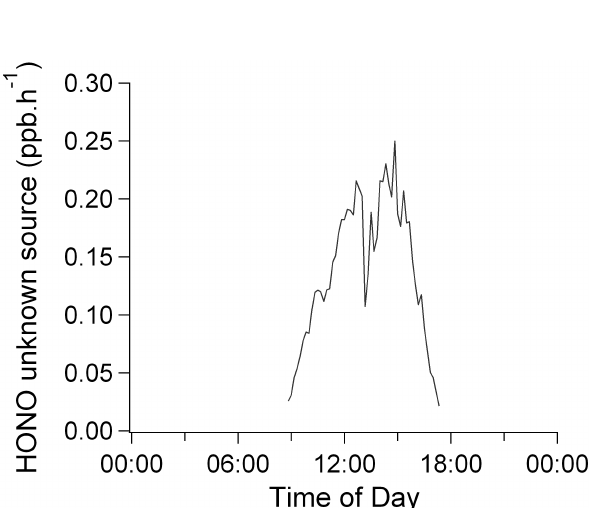
Fig. 13. Mean diurnal profile of the unknown HONO source cal- culated using Eq. (3), during the MEGAPOLI winter campaign at SIRTA observatory (local